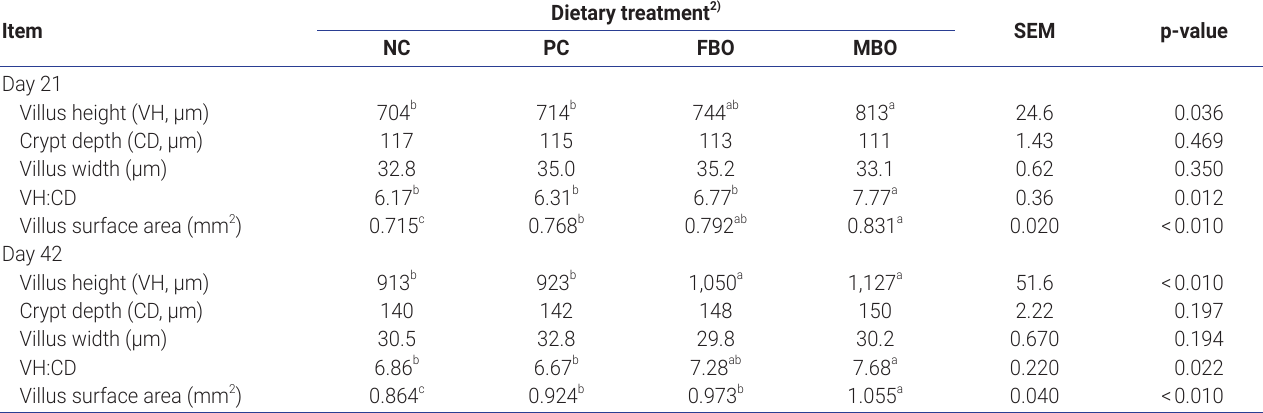
Table 5. Jejunal histomorphology of broiler chickens on day 21 and day 42 1)